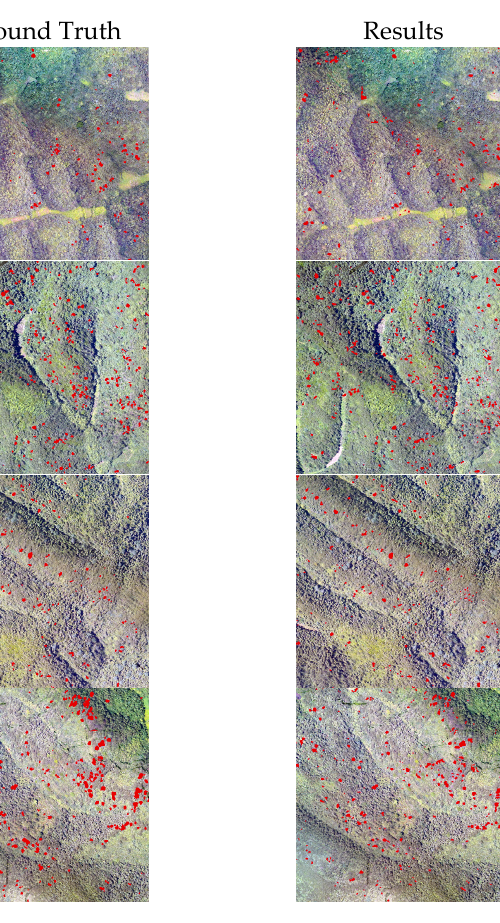
Figure 11. Test area identification results.